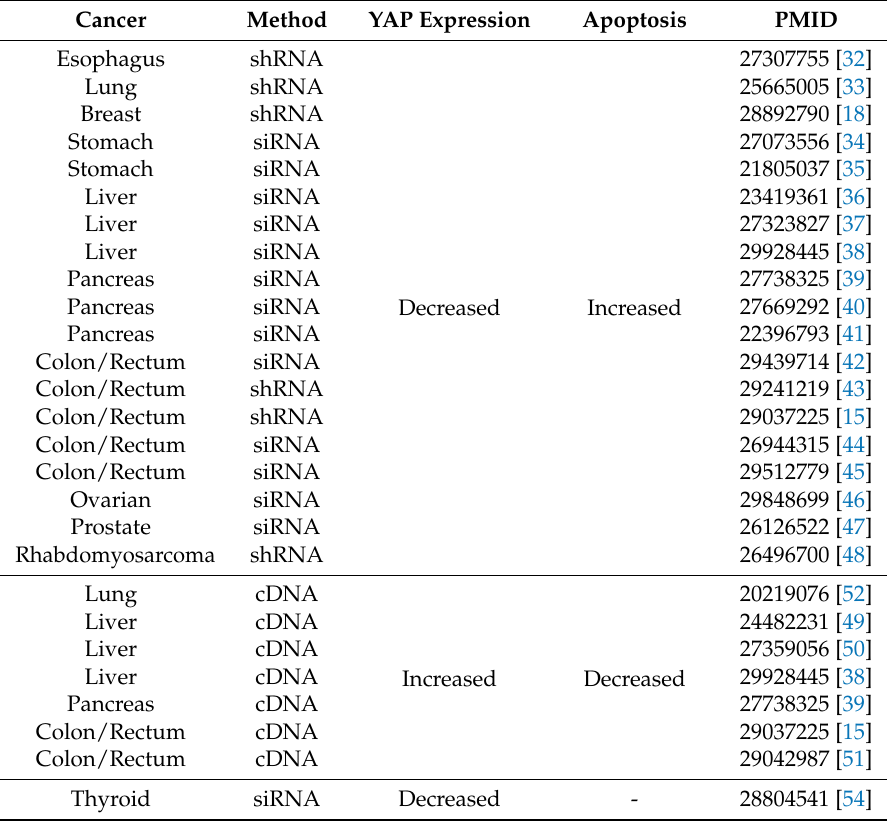
Table 1. Manipulation of YAP expression and its effect on